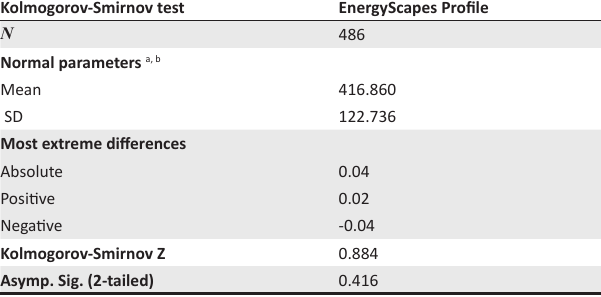
TABLE 3: One-sample Kolmogorov-Smirnov test for the EnergyScapes